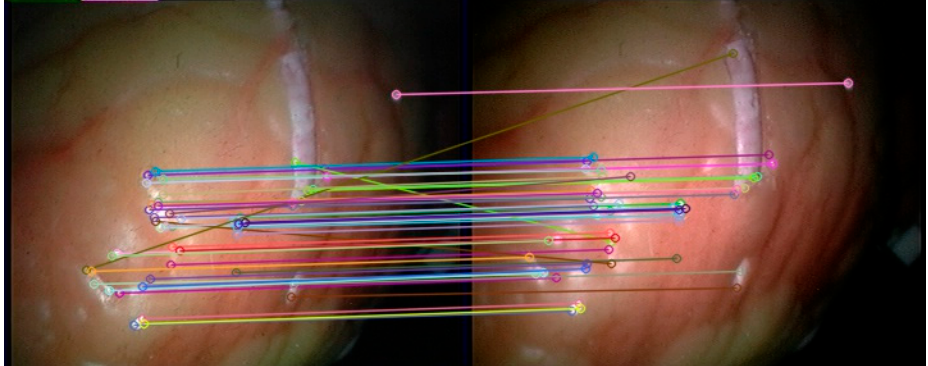
Figure 13. Feature matching results of the method in this paper.